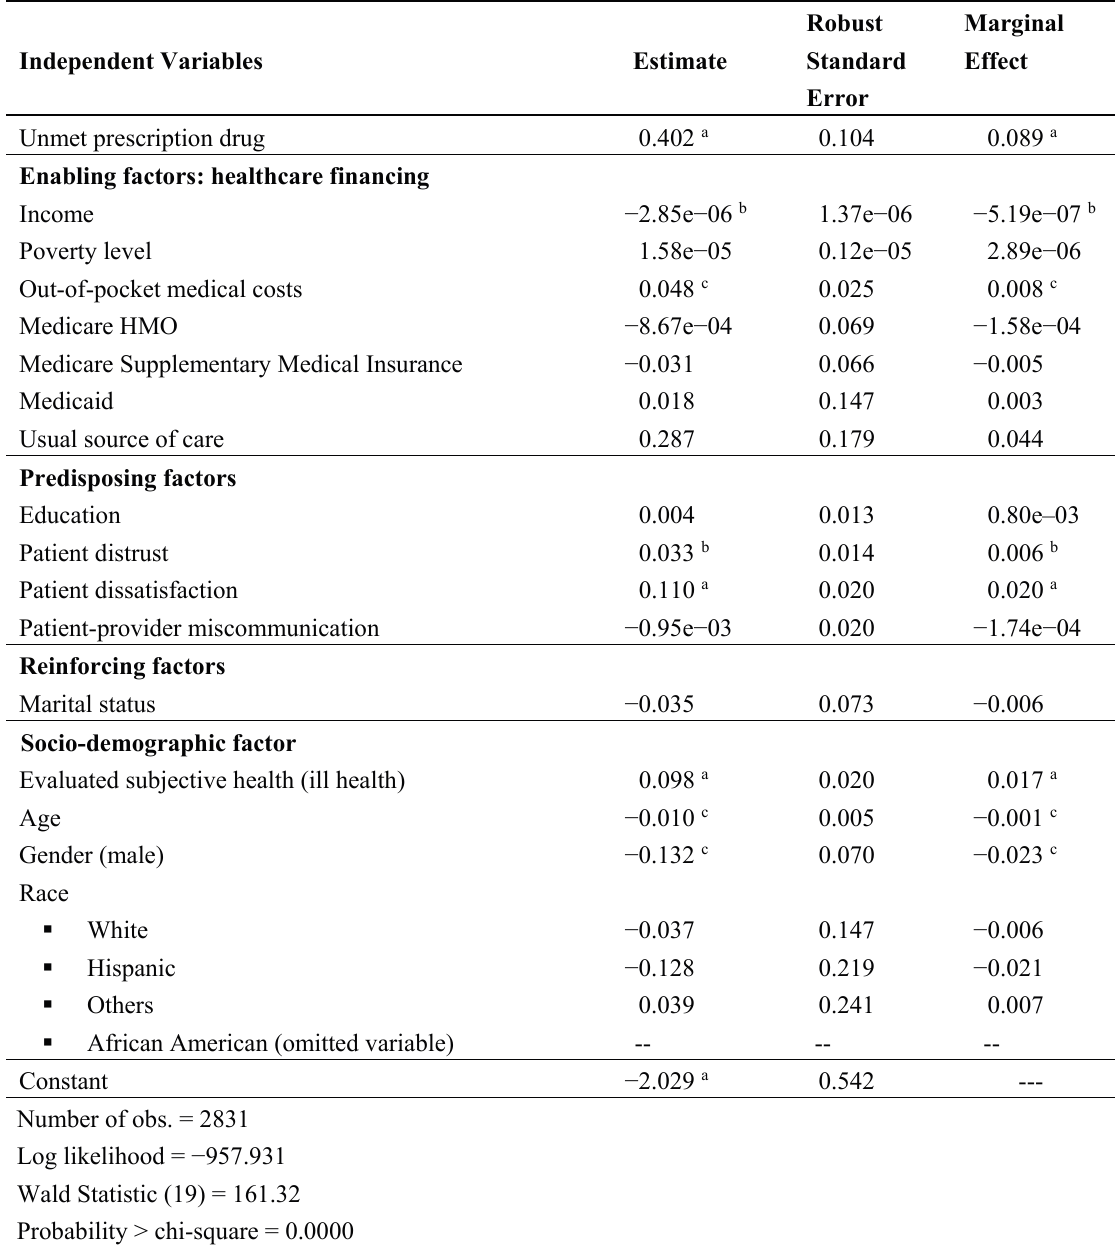
Table 3. Generally perceived delay in healthcare: Results of probit estimation (aged